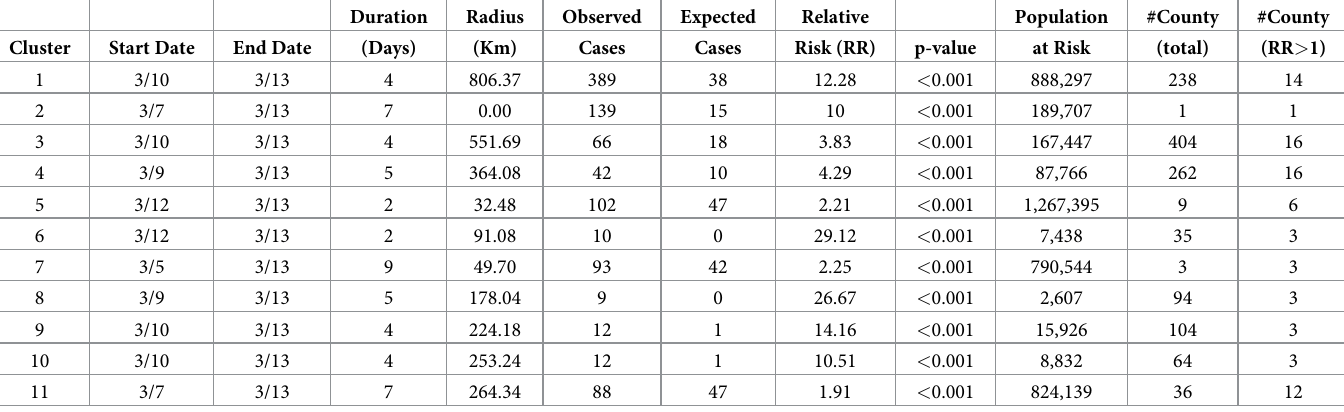
Table 1. Attributes of prospective space-time clusters (hotspots) for COVID-19 from 1/23-3/13/2020 at the county level. Duration Radius Observed Expected Relative